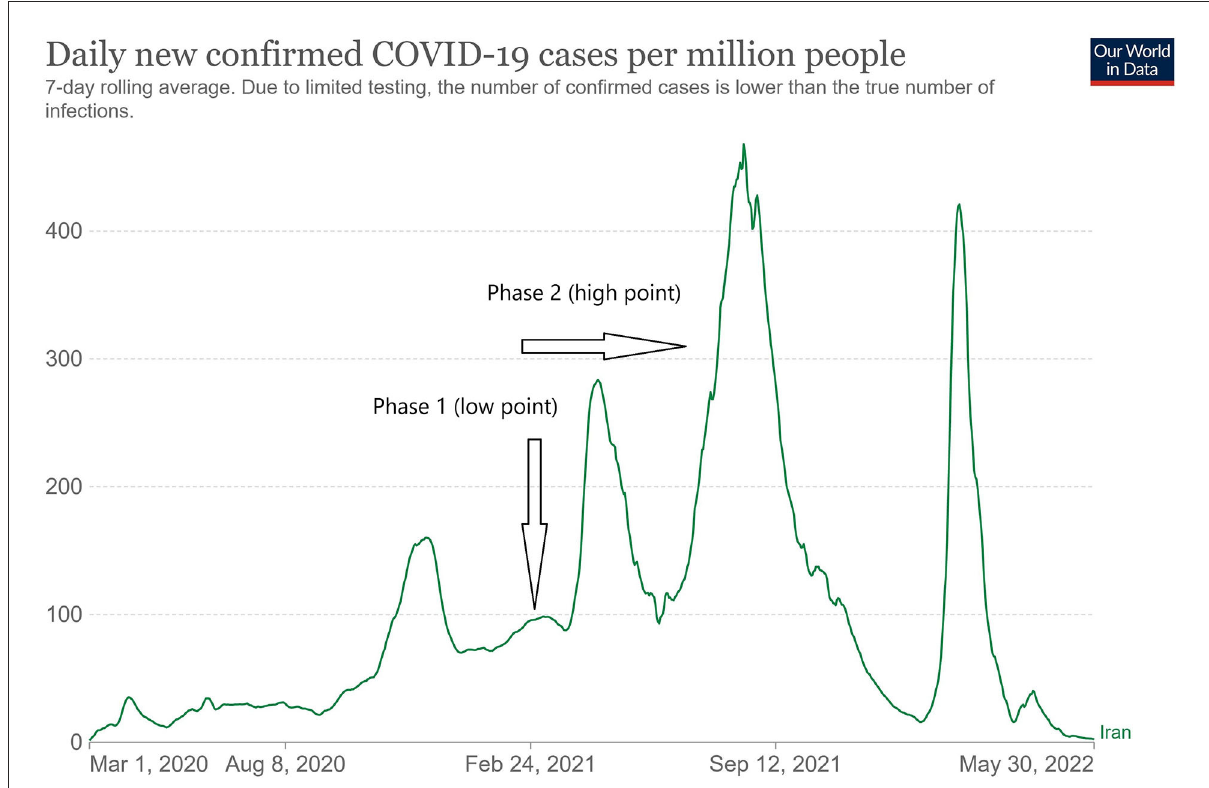
FIGURE1 The trend of the number of daily new COVID-19 cases in Iran (15) and the time of implementation of two studies on vaccine acceptance in Tehran and its rural areas at the low and high points of the